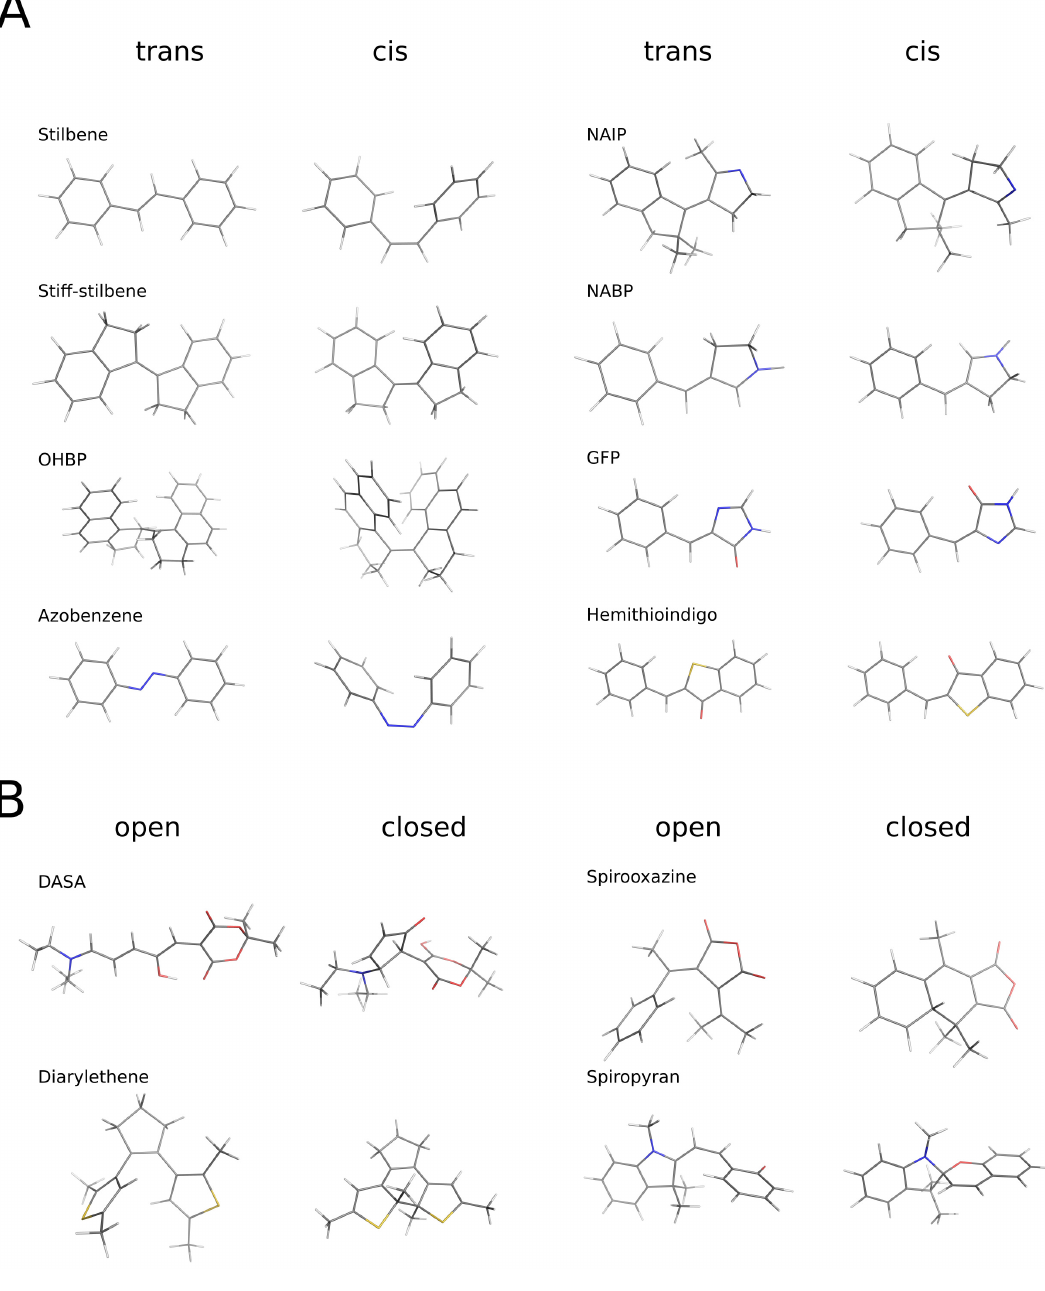
Figure 4. Optimized geometries of photoswitches in trans , cis ( A ), and open/closed ( B ) configurations. Table 1. Characteristics of E/Z optical switches in cis and trans